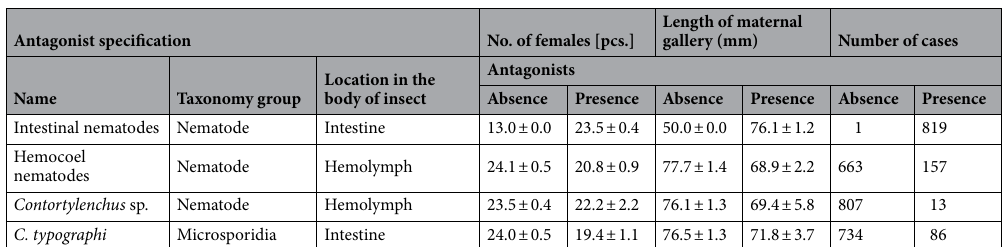
Table 4. Basic statistics (mean ± SE) of gallery pattern and number of I. cembrae females in relation to presence or absence of antagonists of selected taxonomic groups.